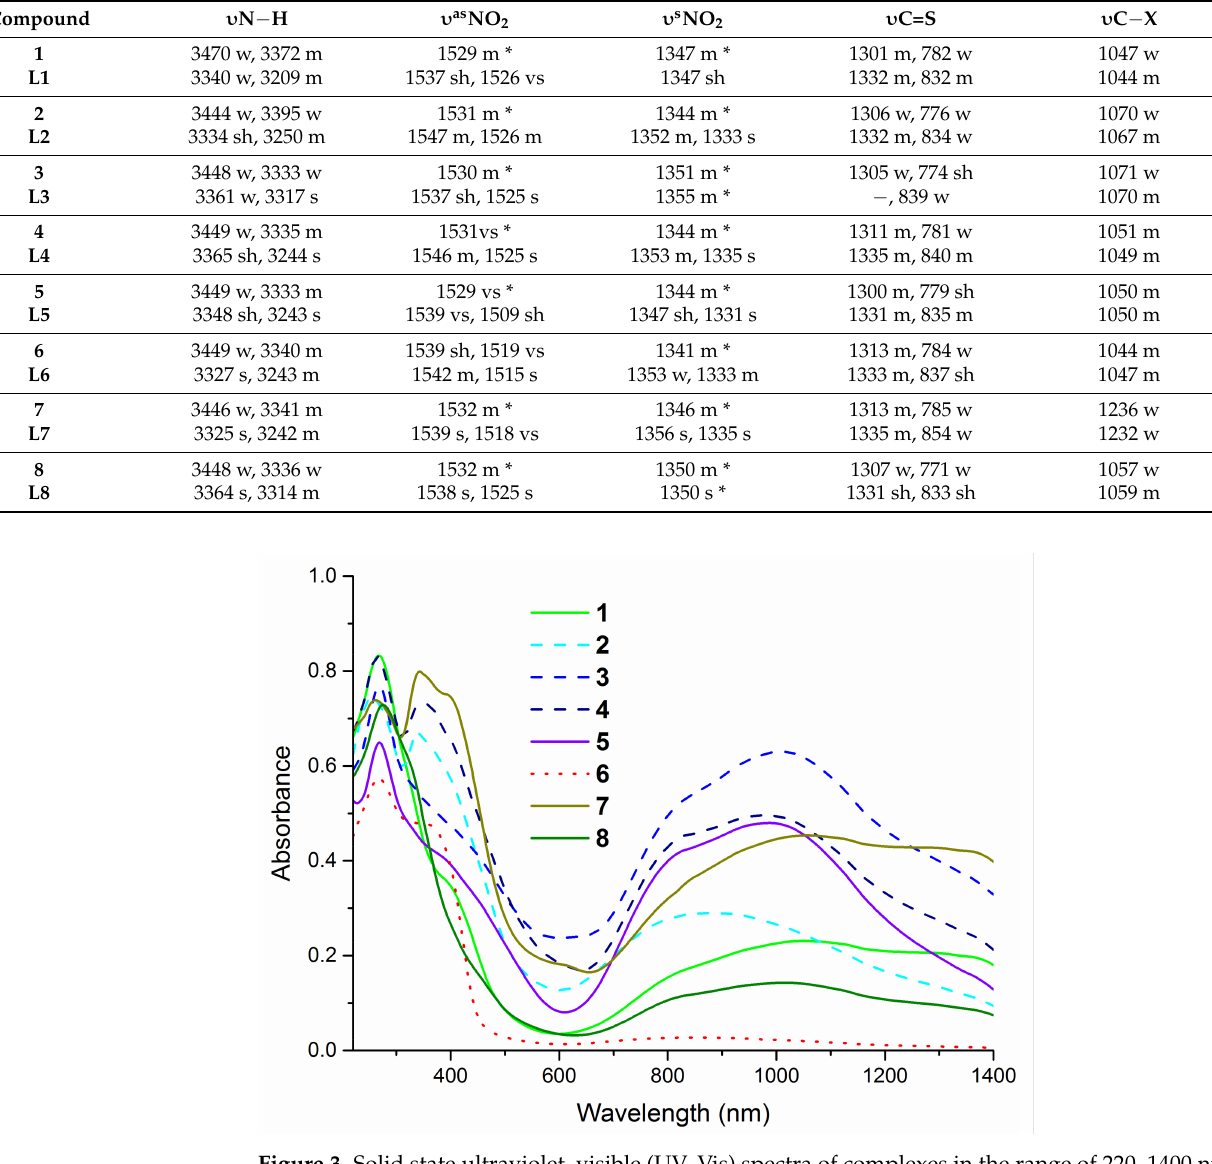
Figure 3. Solid state ultraviolet–visible (UV–Vis) spectra of complexes in the range of 220–1400